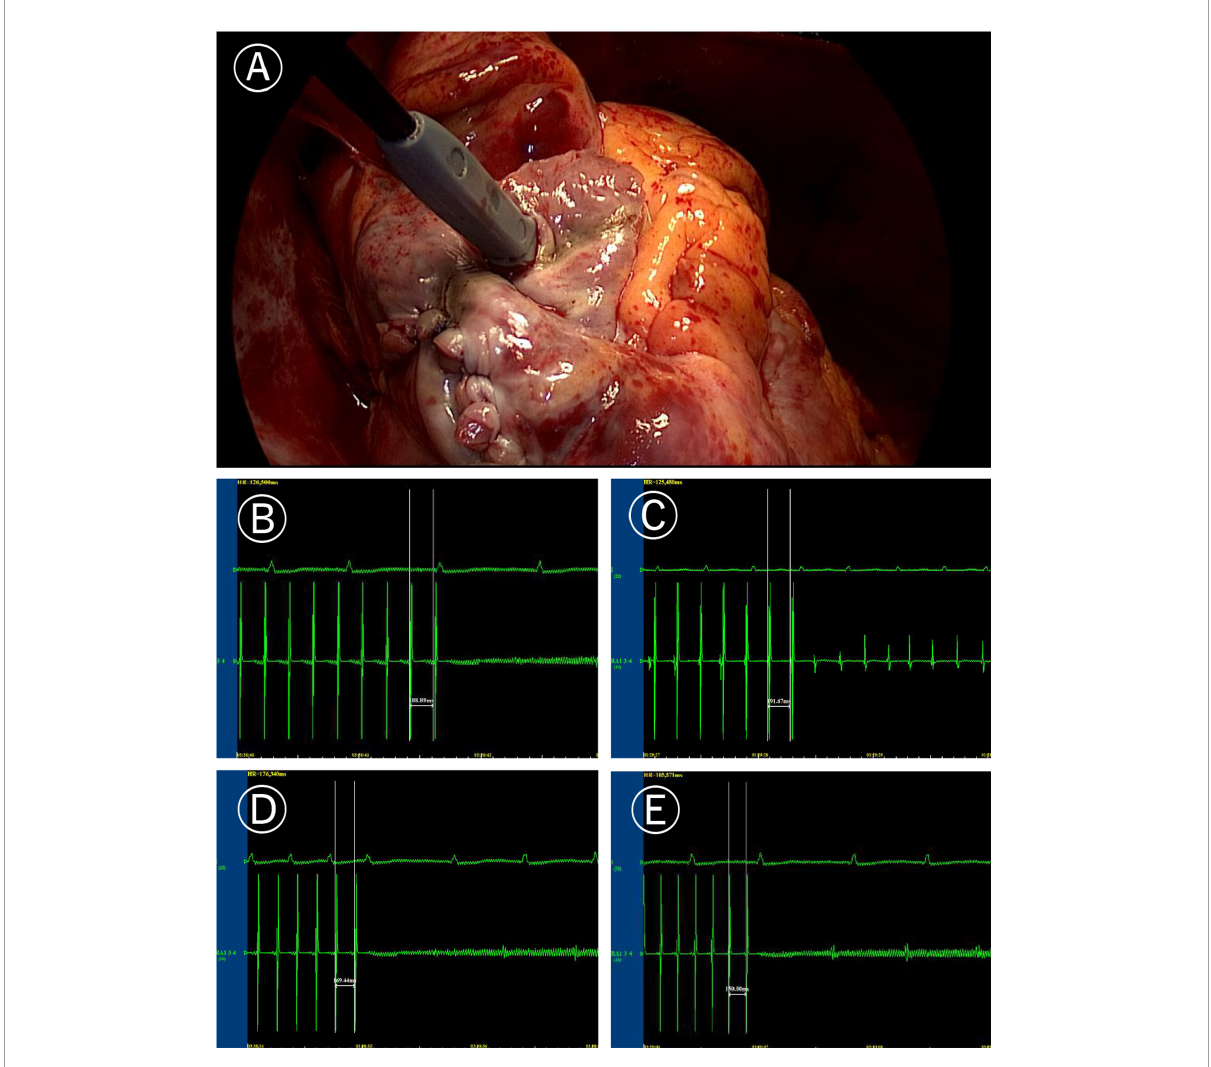
FIGURE1 Induction of atrial fibrillation (AF). (A) Image of programmed stimulation at high right atrial for induction of atrial fibrillation (post surgery). (B) AF induced by the 190 ms cycle stimulation before Cox-Maze IV. (C) After Cox-Maze IV, the 190 ms cycle stimulation failed to induce AF again. (D) After Cox-Maze IV, the 170 ms cycle stimulation could not induce AF; and (E) After Cox-Maze IV, the 150 ms cycle stimulation could not induce AF.